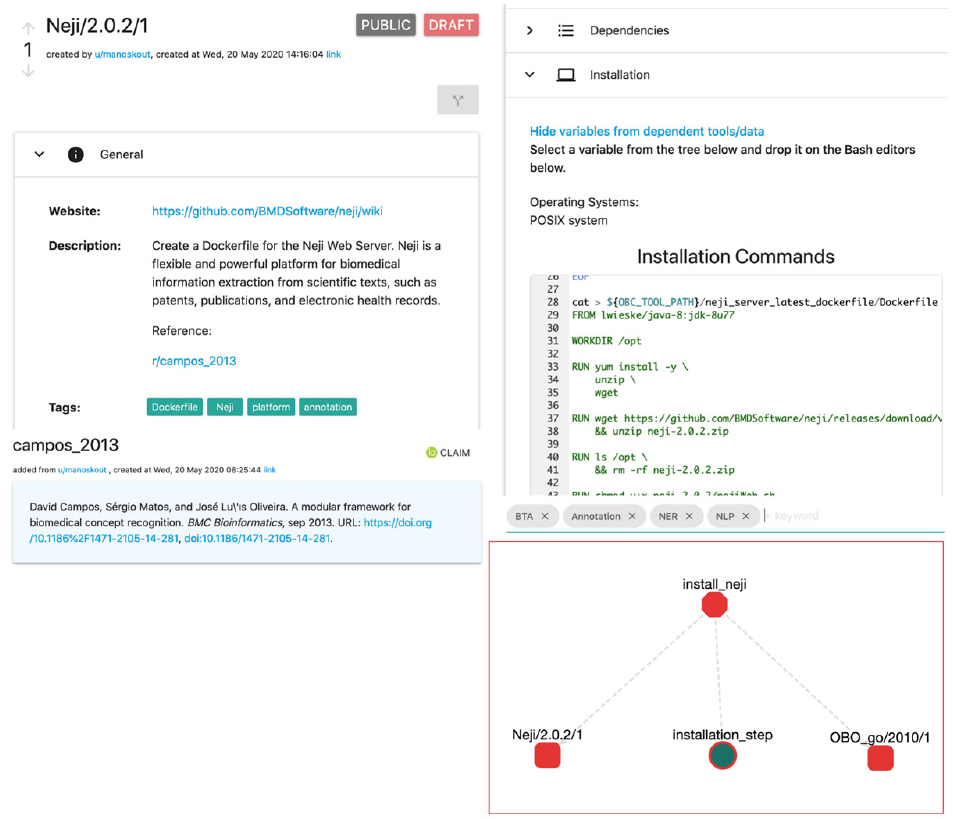
Figure 1. Screenshots of various OpenBio.eu components. A tool (Neji) contains the description, installation instructions, and bibliographic references ( top left ). ROs are accompanied by directly executable source code ( top right ). The lower left shows the scientific paper linked with this tool and the lower right shows a graph with a workflow that uses this tool (Neji) with another RO which is an ontology (OBO Gene Ontology). Table 1. List of all official FAIR principles and how they are addressed in OpenBio.eu. FAIR Principle [21]